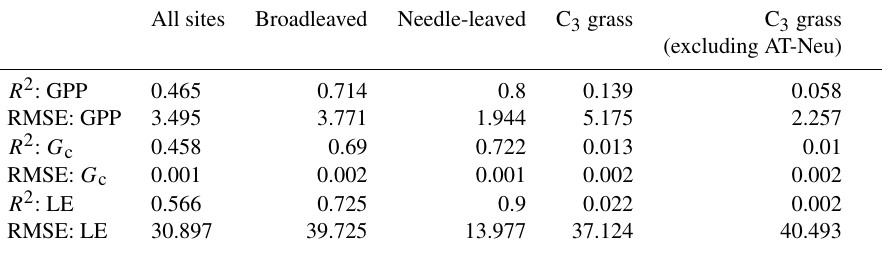
Table A2. Coefficient of determination ( R 2 ) and root mean square error (RMSE) for GPP, canopy conductance ( G c ), and latent heat flux (LE) for all sites and for sites dominated by broadleaved trees, needle-leaved trees, C 3 grass, and C 3 grass excluding the AT-Neu site (outlier). All sites Broadleaved Needle-leaved C 3